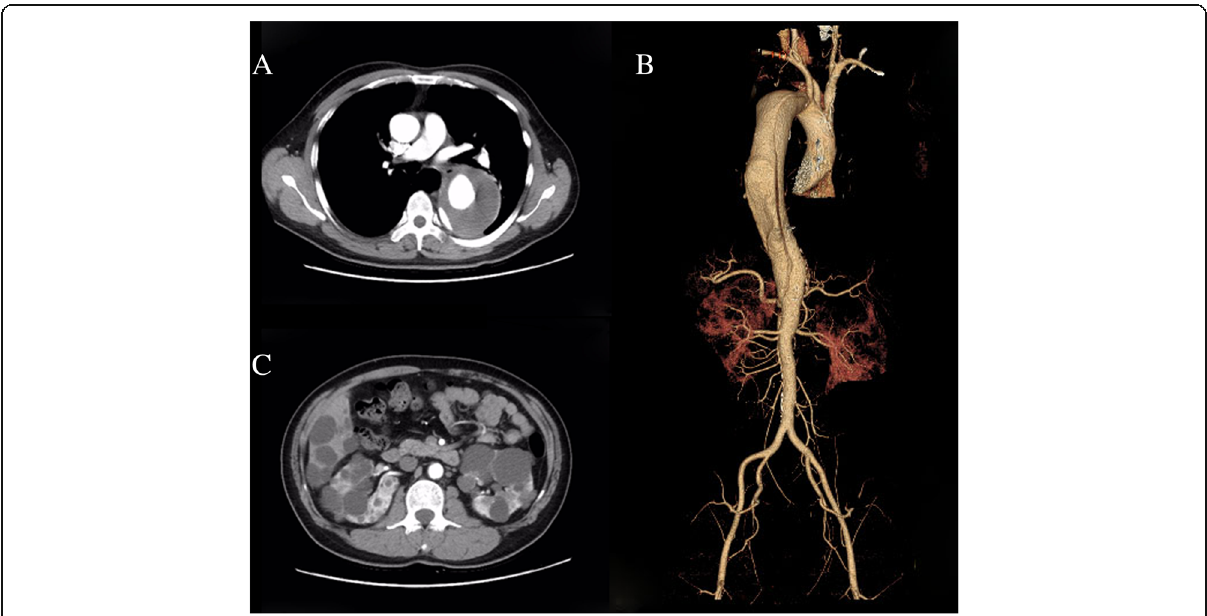
cysts in the liver and bilateral polycystic kidneys